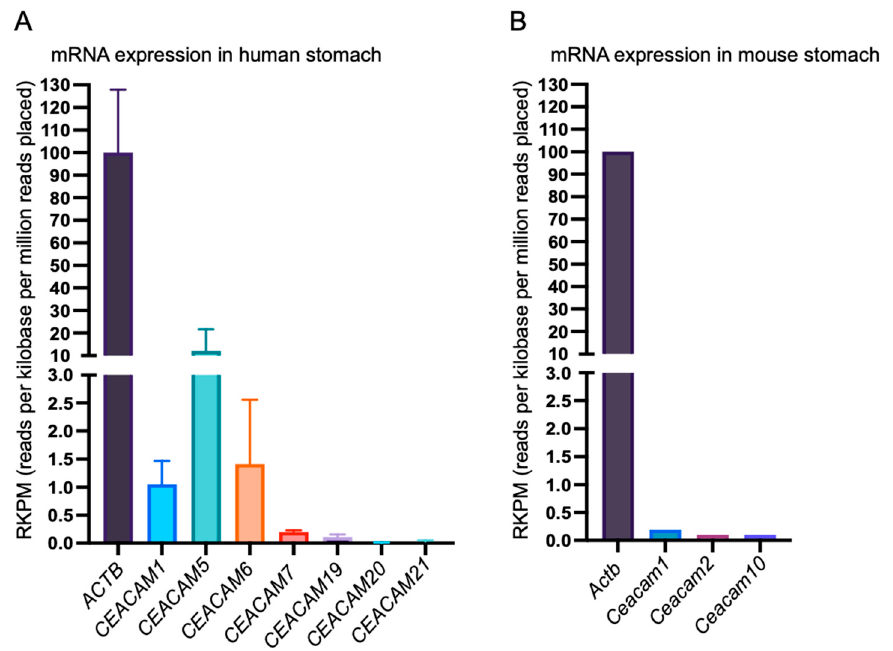
Figure 1. Relative expression levels of human and mouse mRNAs encoding membrane CEACAMs (human) and membrane Ceacams (mouse) in the stomach. Relative levels of human CEACAM1 , CEACAM5 , CEACAM6 , CEACAM7 , CEACAM19 , CEACAM20 , and CEACAM21 mRNA expression compared to ACTB ( β -ACTIN mRNA) in human stomach ( A ). Relative levels of mouse Ceacam1 , Ceacam2 , and Ceacam10 mRNA compared to Actb ( β -Actin ) mRNA in mouse stomach ( B ). It should be noted that the mouse genome does not contain human CEACAM5 , CEACAM6 , and CEACAM7 orthologues, whereas the human genome does not contain a mouse Ceacam2 orthologue.